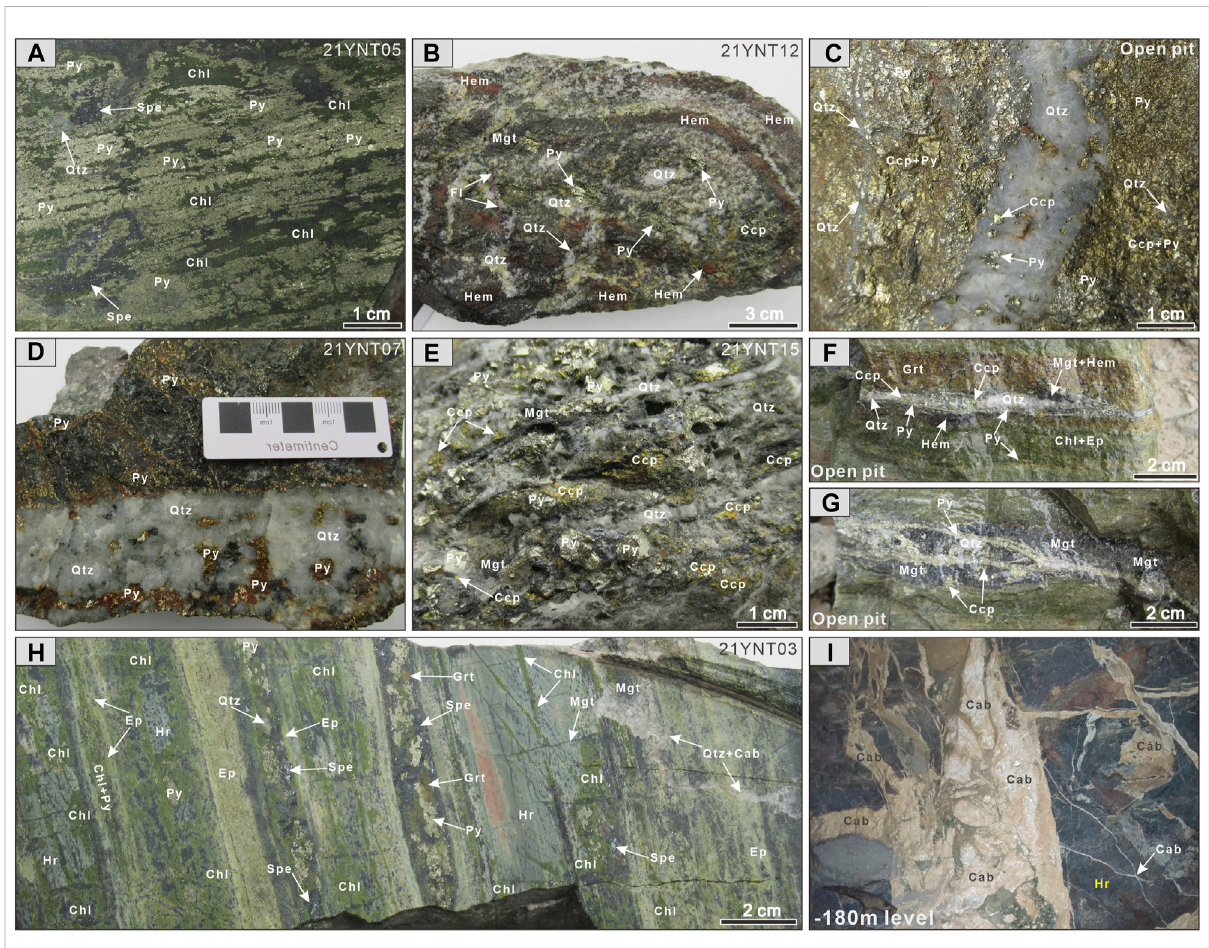
FIGURE 5 Photographs of hand specimens from the Tongjing Au – Cu deposit. (A) Striped Au ore with specularite precursor, accompanying chlorite and pyrite; (B) Au – Cu ore including chalcopyrite, pyrite and magnetite and hematite relic, cut by later quartz and fl uorite veinlets; (C) Chalcopyrite – pyrite – quartz vein cutting the massive Au – Cu ore; (D) Pyrite – quartz vein cutting the disseminated Au ore; (E) Au – Cu ore with magnetiterelics,crossedbylaterquartzveinlets; (F,G) Garnetorepidoteskarnwithmagnetiteandhematite,cutbychalcopyrite – pyrite – quartz vein; (H) Au – Cu ore showing striped sul fi des and oxides, reddish and grey hornstone, epidote, chlorite and garnet relic. Most specularite and magnetite are replaced by pyrite in situ , the irregular (pyrite – ) chlorite veins cutting hornstone or magnetite vein, with late carbonate – quartz vein cutting the ore; (I) Multistage carbonate veins cutting early dark grey hornstone. Abbreviations: Cab – carbonate; Ccp – chalcopyrite; Chl – chlorite; Ep – epidote; Fl – fl uorite; Grt – garnet; Hem – hematite; Hr – hornstone; Mgt – magnetite; Py – pyrite; Qtz – quartz; Spe –